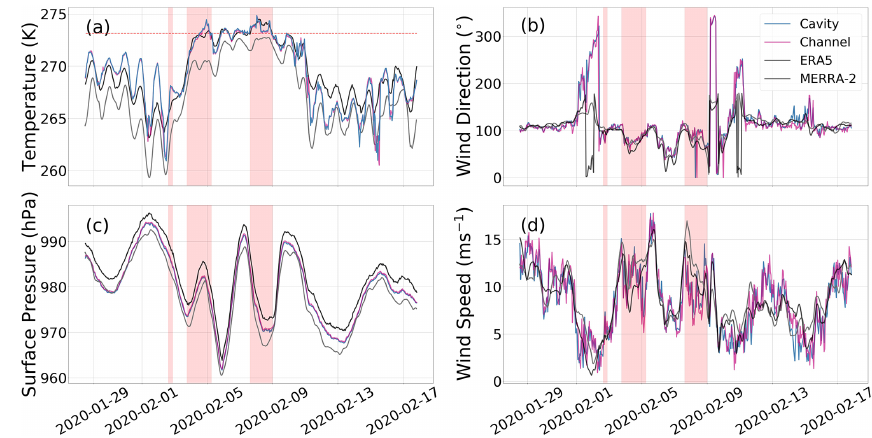
Figure 7. Observations of (a) 2m temperature, (b) wind direction, (c) surface pressure, and (d) wind speed during the AR family event from AMIGOS at Cavity Camp (blue) and Channel Camp (pink) sites, and MERRA-2 (gray) and ERA5 (black) reanalyses. Pink shading indicates the timing of the AR events, based on the Wille et al. (2019) AR detection algorithm.